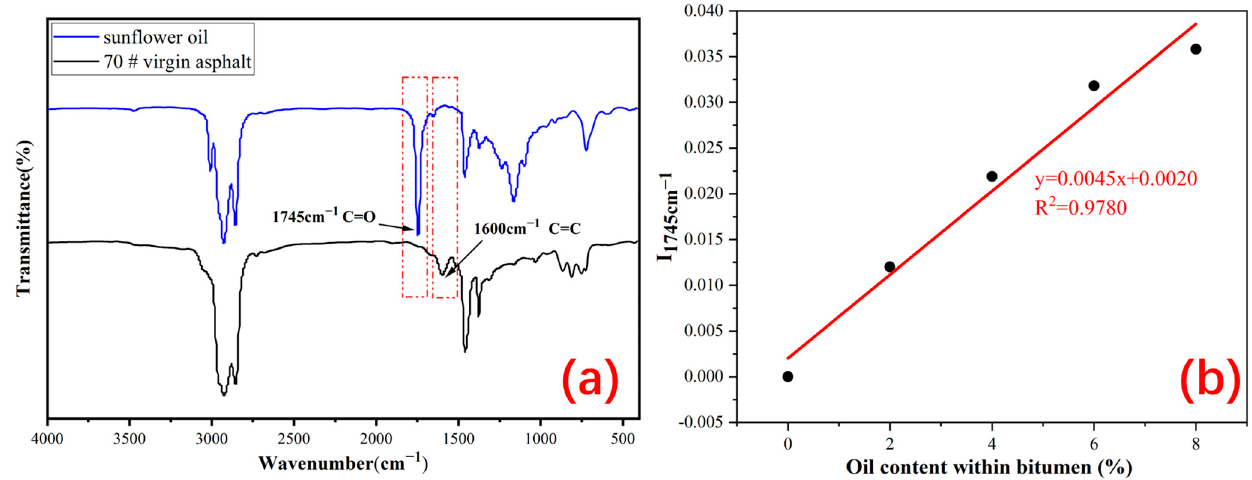
Figure 4. ( a ) Infrared spectra of virgin asphalt and sunflower oil and ( b ) the standard curve between I 1745cm − 1 and the rejuvenator content within the virgin asphalt.